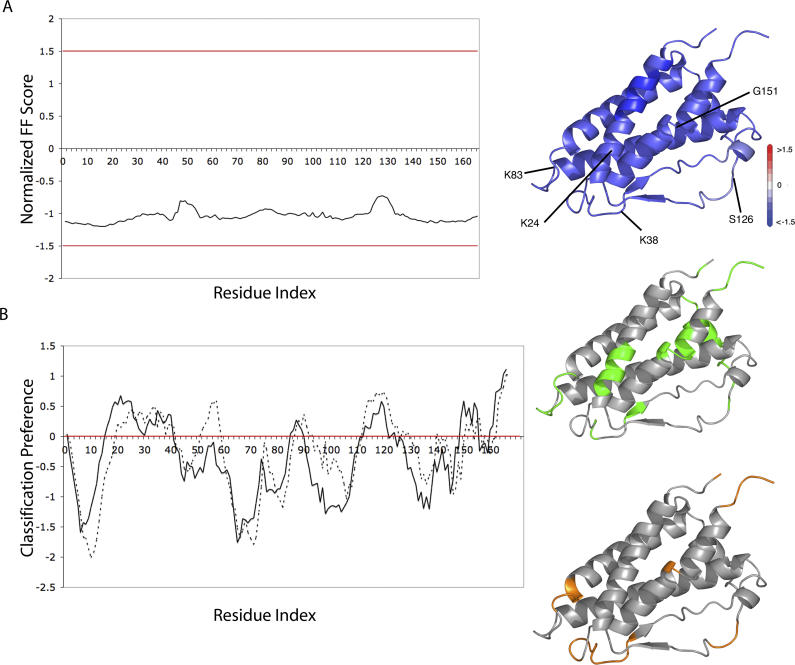
Wiggle Predictors Identify Regions Corresponding to Glycosylation Sites on Erythropoietin(A) FF score plotted against residue number with thresholds shown in red. Erythropoietin is modeled by the GNM in the complexed form with the corresponding receptor (not shown). All residues have below mean fluctuation (colored blue), but none of the residues are defined as FFRs since they do not exceed the definition threshold. The four glycosylation sites (S126 and lysine substituted K24, K38, and K83) along with G151 are labeled. (PDB ID: 1EER)(B) FFRs correspond to positive values as predicted by Wiggle (solid line) and Wiggle200 (dashed line) which are structurally mapped onto erythropoetin (green and orange, respectively). Not all loops are identified by the predictors to be functionally flexible, thus showing that discrimination is not based on structural features.